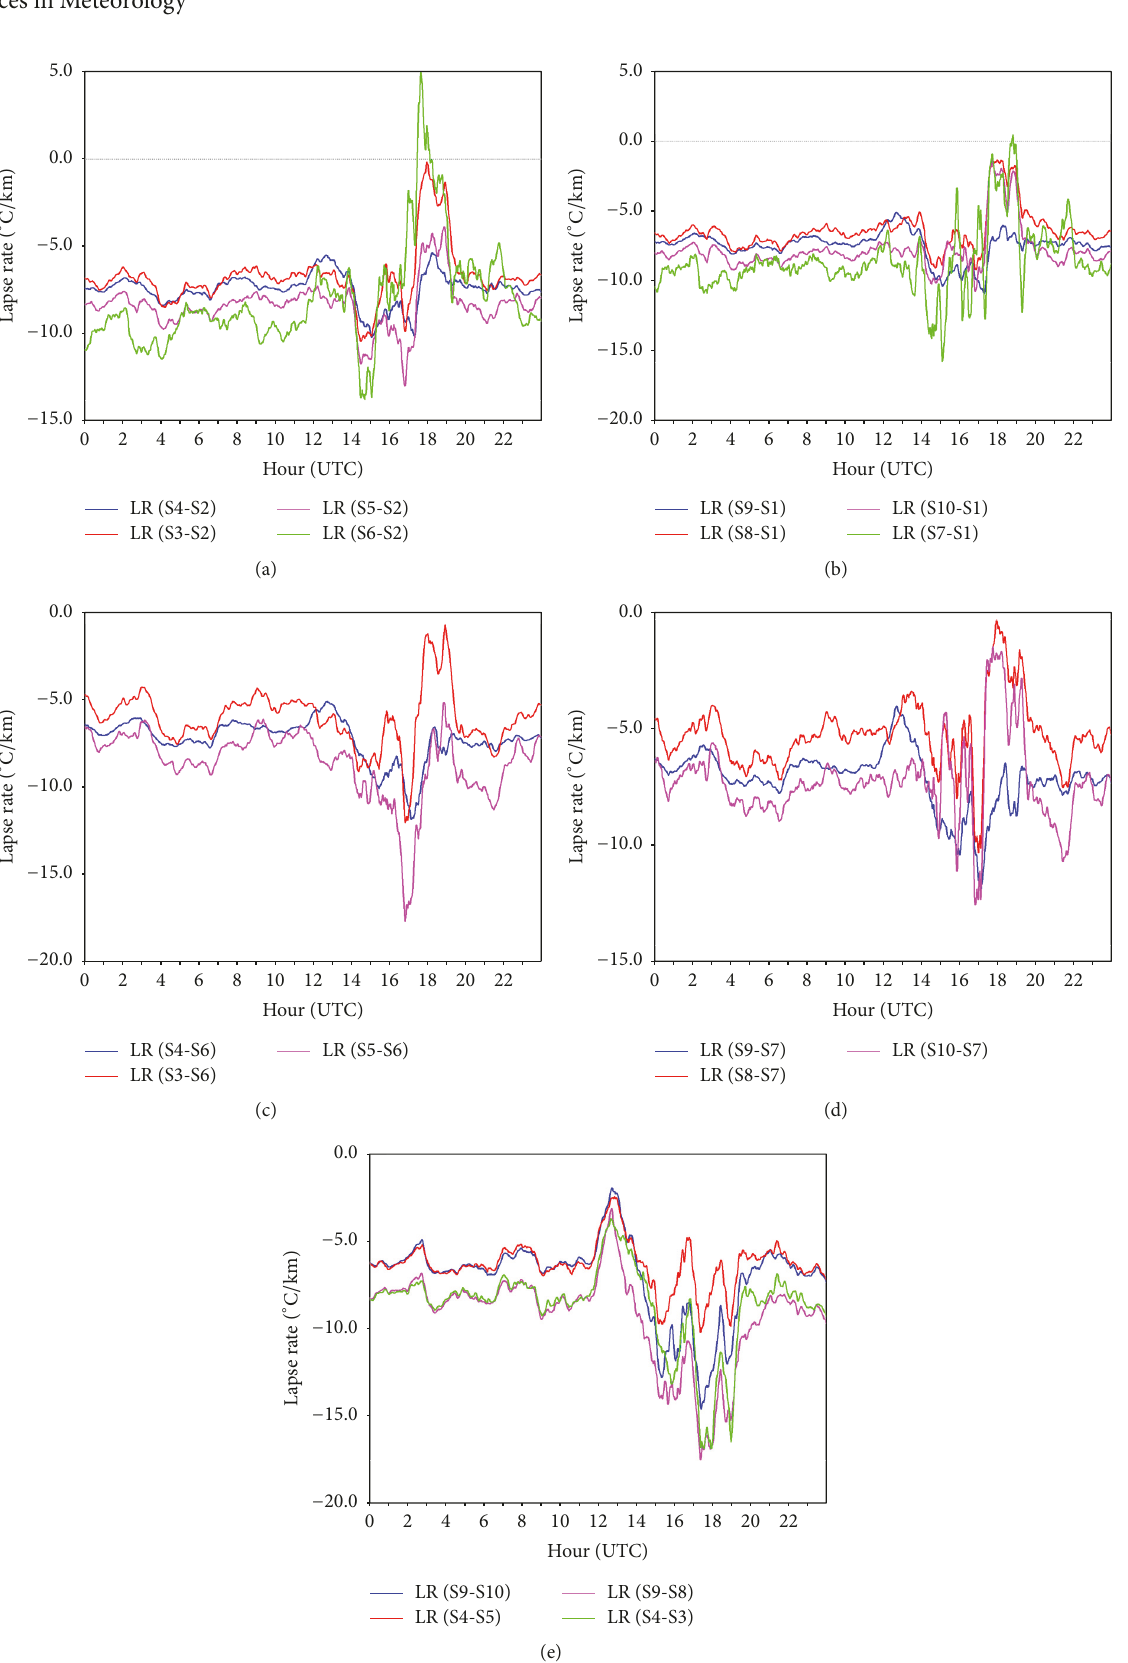
Figure 8: Mean daily profile (22–26 March 2015) of lapse rate data (a) between Station S2 and other stations; (b) between Station S1 and other stations; (c) between Station S6 and other stations; (d) between Station S7 and other stations; and (e) between different